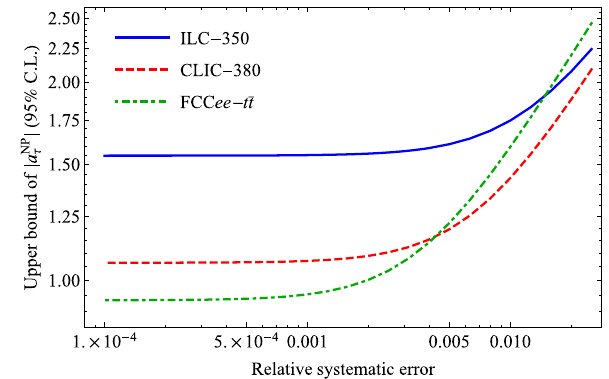
Fig. 7 The95%CLupperboundsof a NP τ asfunctionsofthesystematic error for the ILC-350, the CLIC-380, and the FCC ee - t ¯ t experiments with the designed integrated luminosities of 0.2, 1.0, and 1.7 ab − 1 , respectively